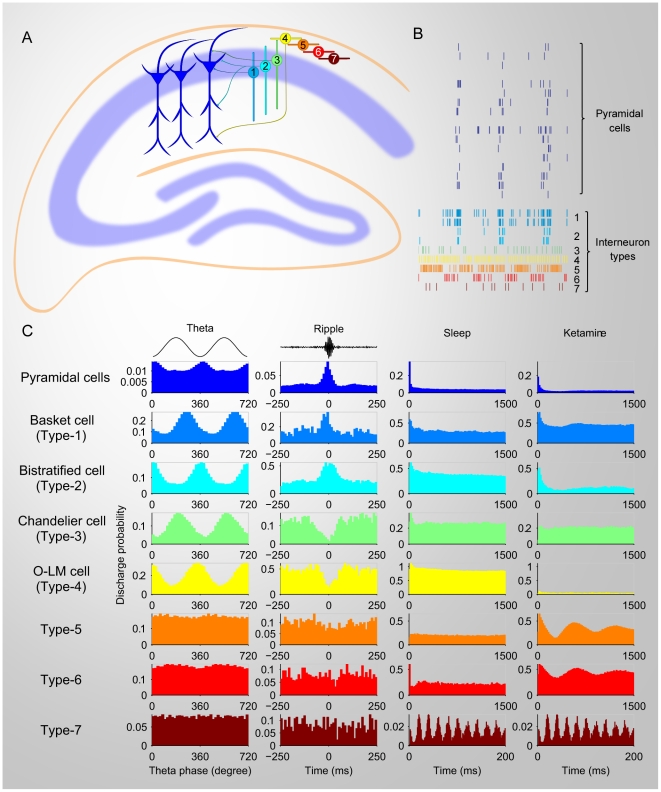
Summary of distinct firing dynamics of pyramidal cells and 7 different types of interneurons in CA1.(A) The chart illustrates the anatomical positions of pyramidal cells and interneurons. Type-1 (basket cell), type-2 (bistratified cell) and type-3 (chandelier cell) are positioned in the pyramidal cell body layer in the hippocampus CA1 subregion. Type-4 (O-LM cell), Type-5, type-6, and type-7 interneurons located in the str. oriens. (B) Firing temporal rhythms of pyramidal cells and seven distinct types of interneurons under ketamine anesthesia. (C) Distinct profiles of distinct CA1 cells in relationship with theta oscillations (the first columns of plots from left), ripples (second colomun), and their autocorrelograms during sleep (third column) and ketamine-induced anesthesia (right column).